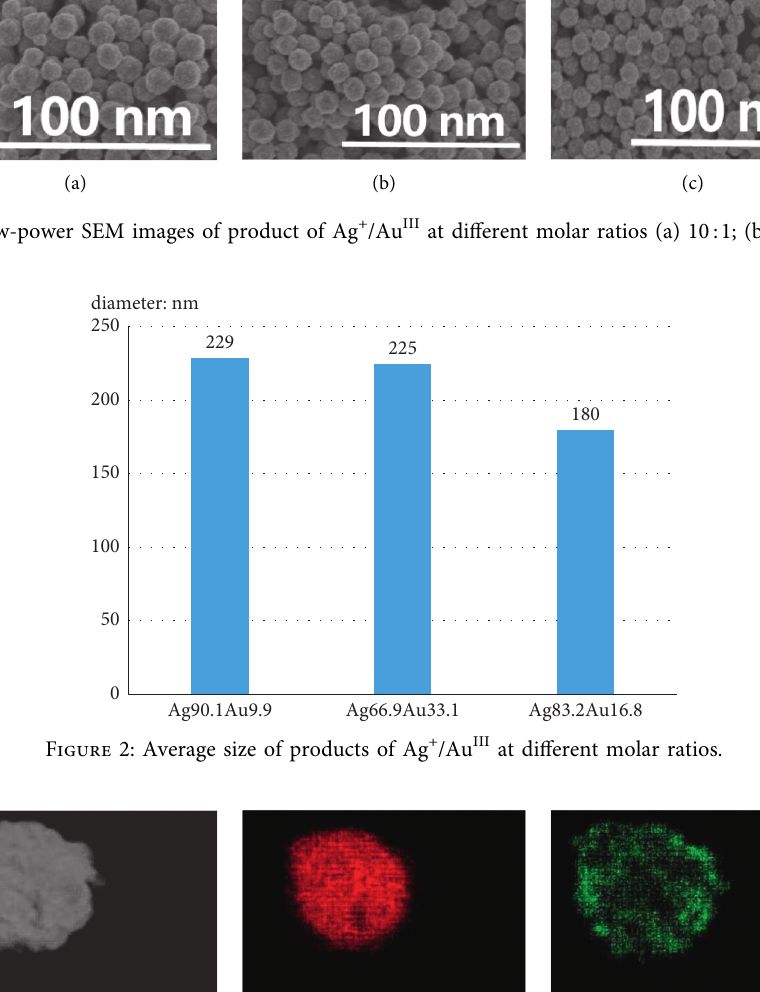
66.9 –Au 33.1 : (a) HADDF-STEM image; (b) Ag;